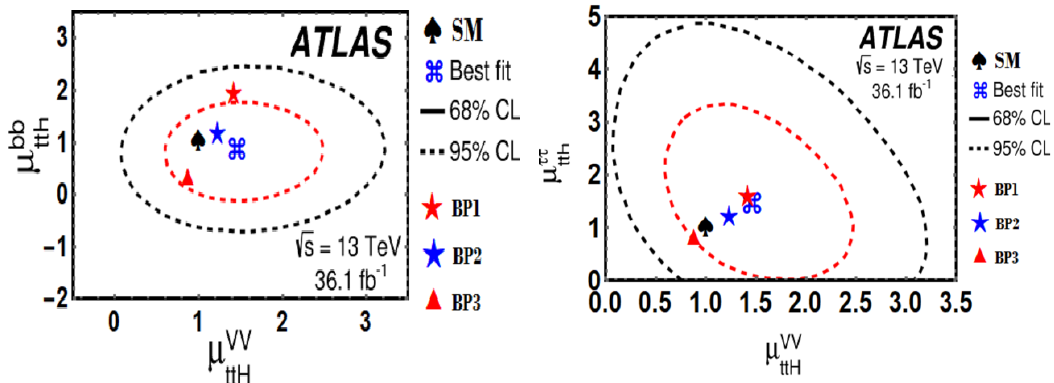
Figure 5 . The two-dimensional best-(cid:12)t of the signal strength modi(cid:12)ers for the processes t (cid:22) th; h ! b (cid:22) b versus t (cid:22) th; h ! V V ? ; ( V = W; Z ) (left) and t (cid:22) th; h ! (cid:28) + (cid:28) (cid:0) versus t (cid:22) th; h ! V V ? ; ( V = W; Z ) (right). Three benchmark points (BP) are also shown in this contour